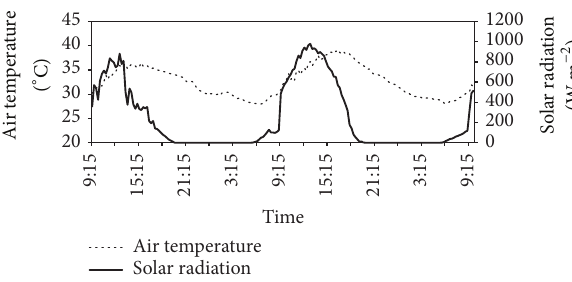
Figure 4: Air temperature and solar